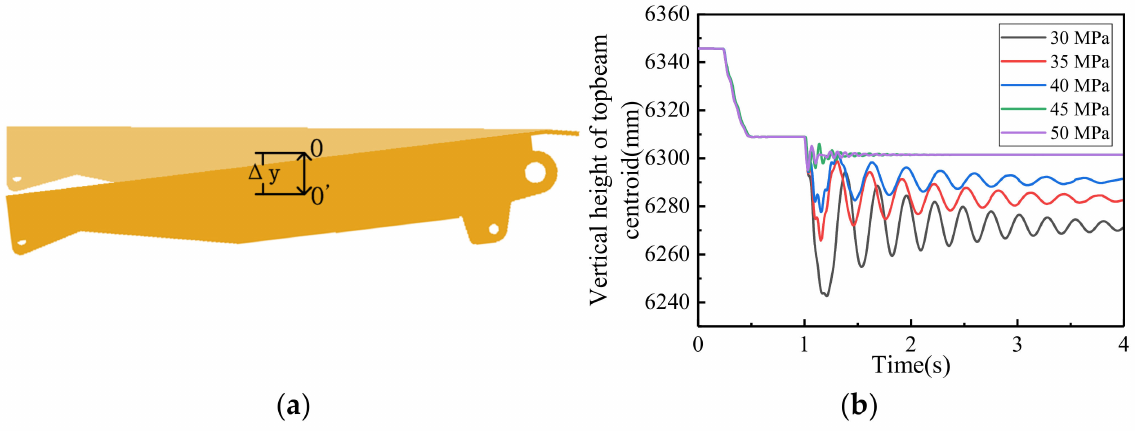
Figure 11. ( a ) Schematic diagram of vertical displacement change in the centroid of top beam. ( b ) Displacement change in vertical direction of the centroid of top